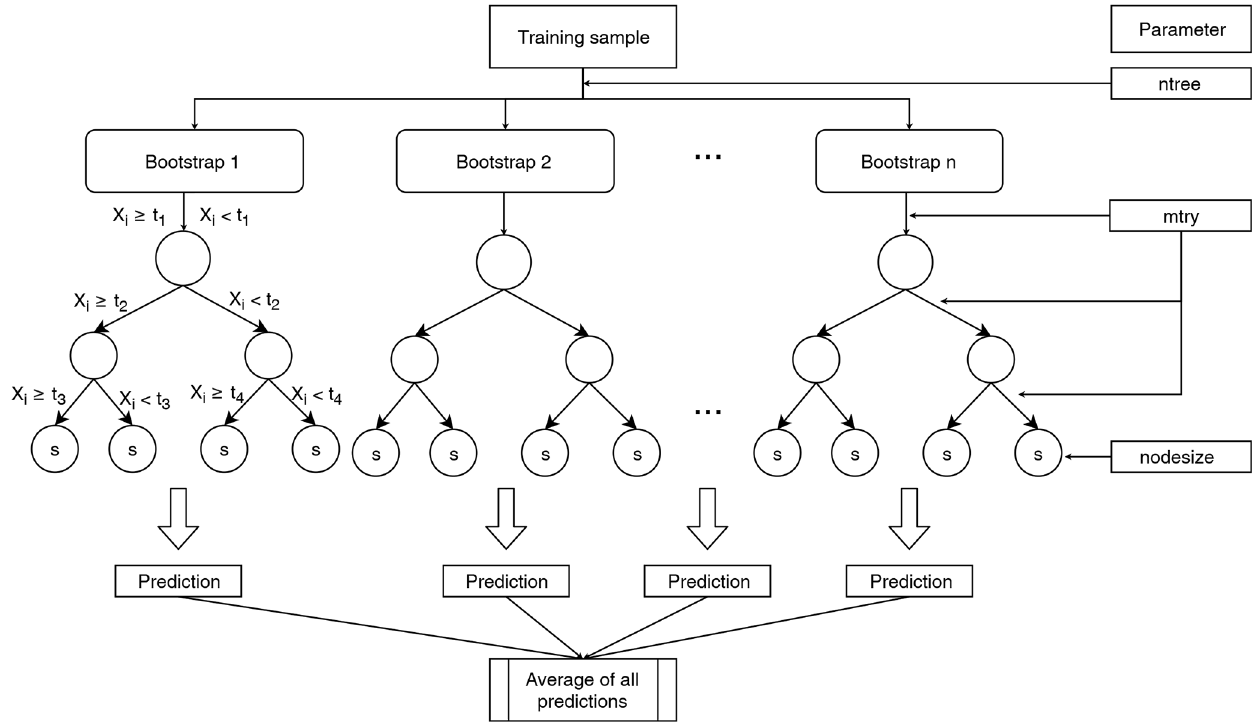
Figure 2. Structure of an RF and relevant